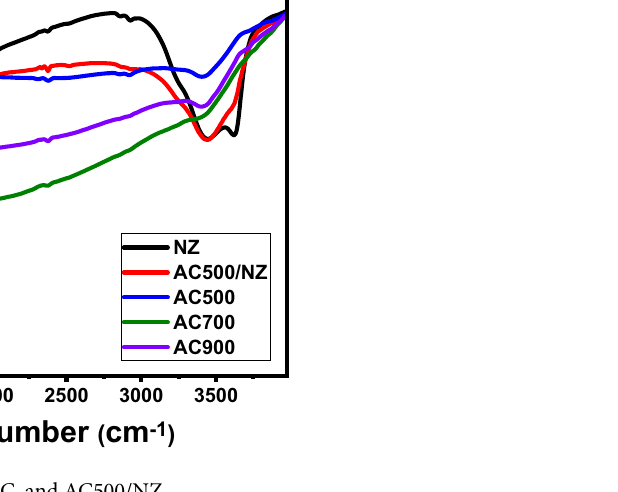
Figure 3. FTIR spectra of NZ, AC, and